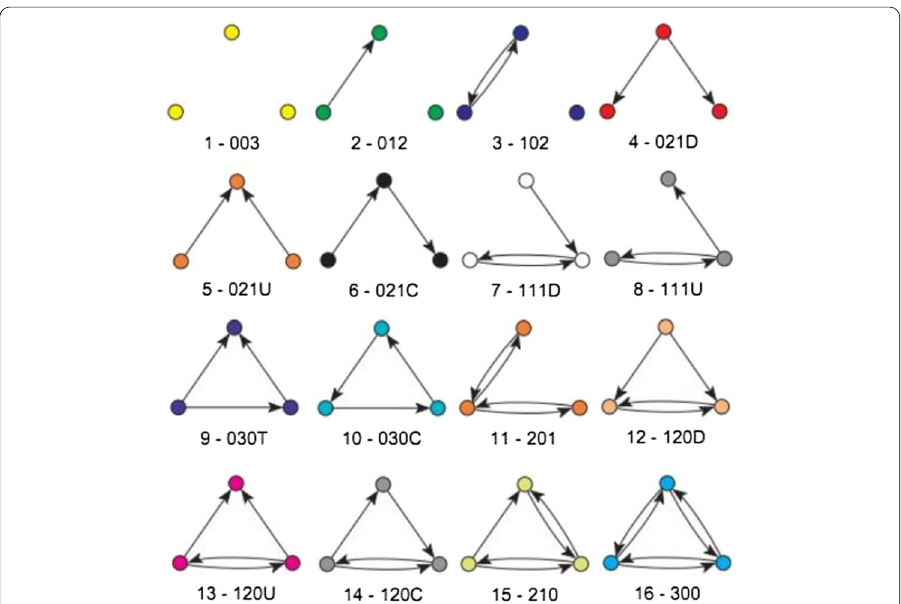
Fig. 3 The 16 isomorphic triad classes, with M-A-N labeling. The first digit (M) represents the number of mutual ties, the second (A) represents the number of asymmetric ties, and the third (N) represents the number of null, or nonexistent ties between dyads. The optional letter represents the directions of asymmetric edges (“D” for down, “U” for up, “T” for transitive, and “C” for